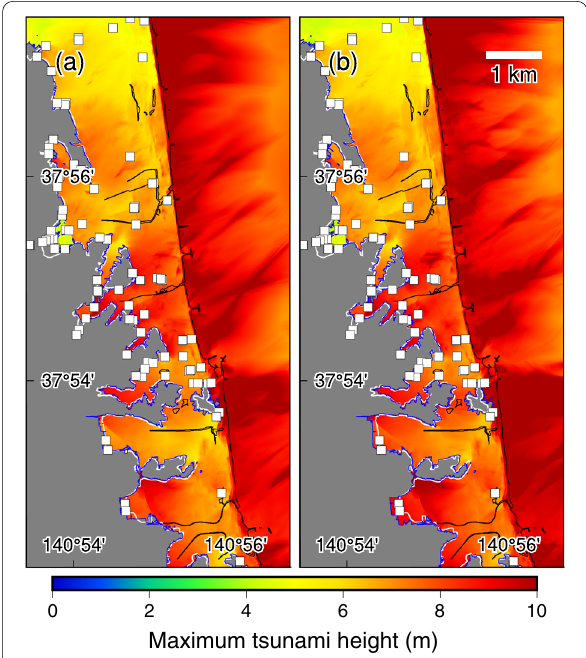
Fig. 7 Distributions of the maximum tsunami height attributed to a se3510 and b se4005. White and blue lines indicate the observed and simulated inundation limits